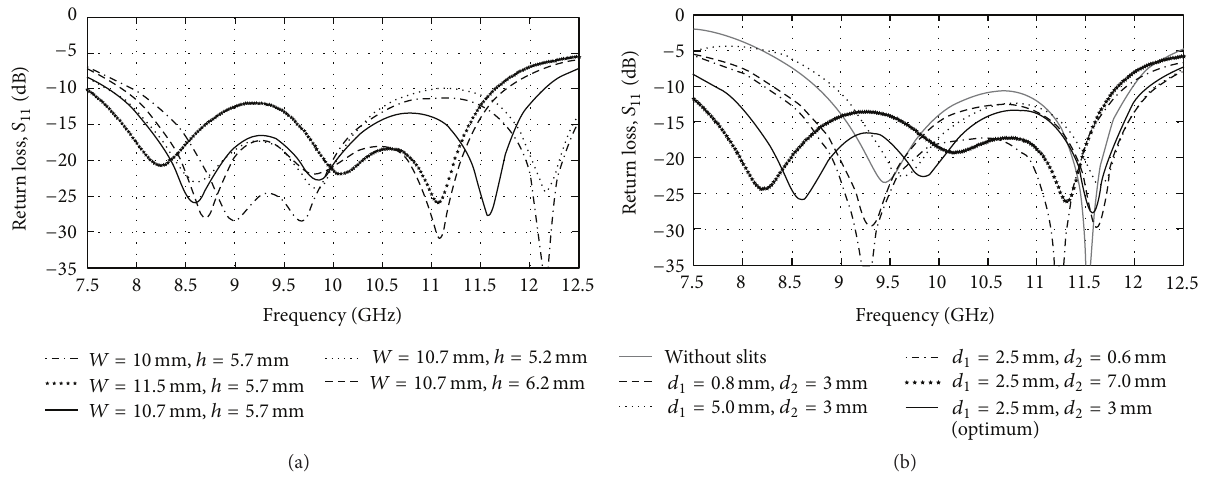
Figure 2: Simulated return losses of the antenna without FSS (see Figure 1(a)) for different values of (a) 𝑊 and ℎ in the feeding stub ( 𝑑 1 = 2.5 and 𝑑 2 = 3 mm) and (b) 𝑑 1 and 𝑑 2 , the parameters of the slits ( 𝑊 = 10.7 , ℎ = 5.7 , and 𝑑 3 = 6.7 mm).